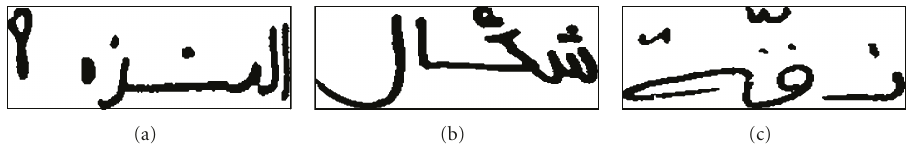
Figure 8: Example of samples that are misrecognized by classical HMMs but they are correctly recognized by HMMs with explicit state duration since the character duration allows accurate character identification.